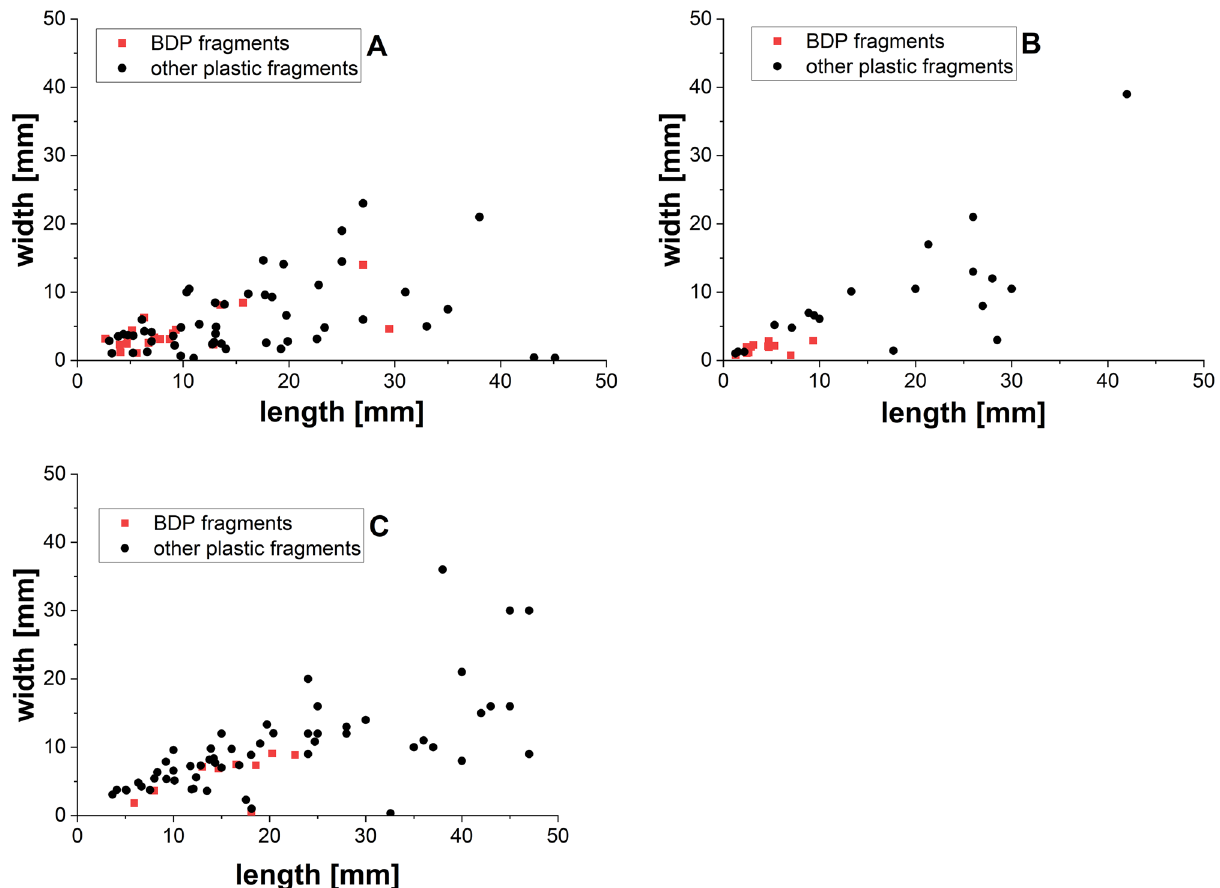
Figure 2. Size distribution of plastic fragments > 1 mm. ( A ) Fragments found in the finished compost from plant #1, ( B ) in the finished compost from plant #2, and ( C ) in the pre-compost from plant #3. For reasons of statistical relevance, only samples containing more than 20 BDP fragments per kg of compost were included in the